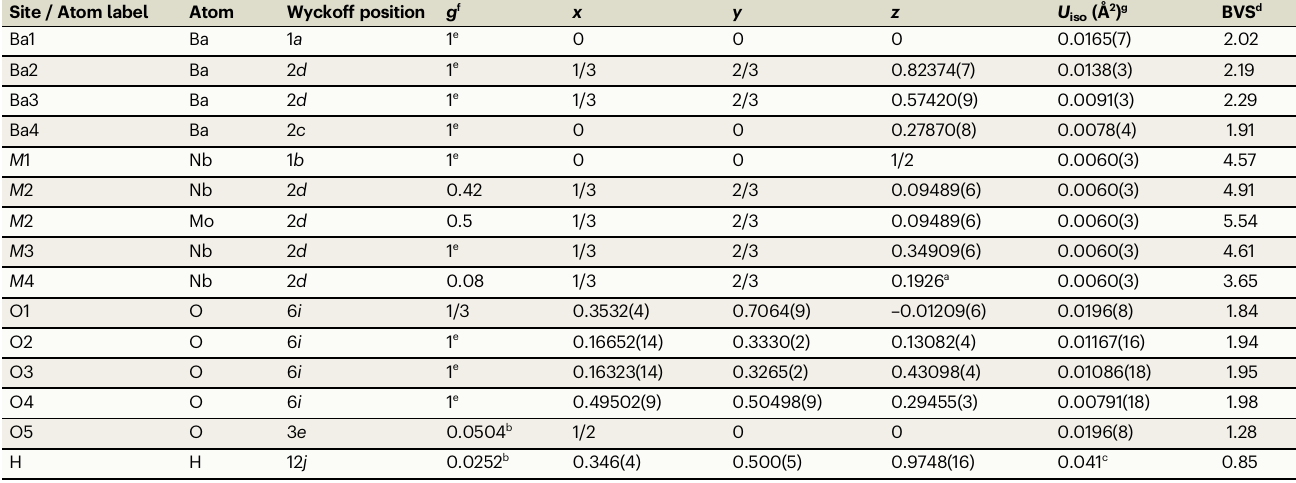
Table 2 | Re fi ned crystal parameters and reliability factors in Rietveld analysis of the neutron diffraction data of Site / Atom